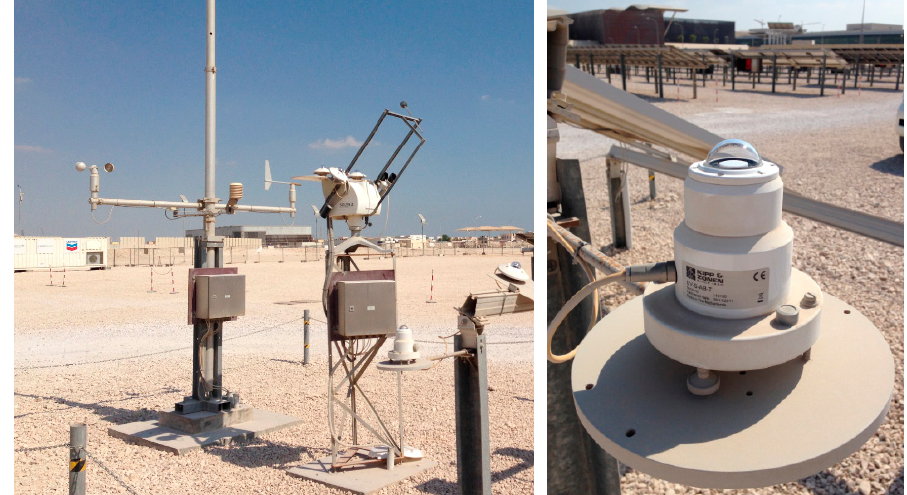
Figure 2. The ground-based analyzers from QEERI’s Outdoor Test Facility (OTF) in Education City, Doha, Qatar.